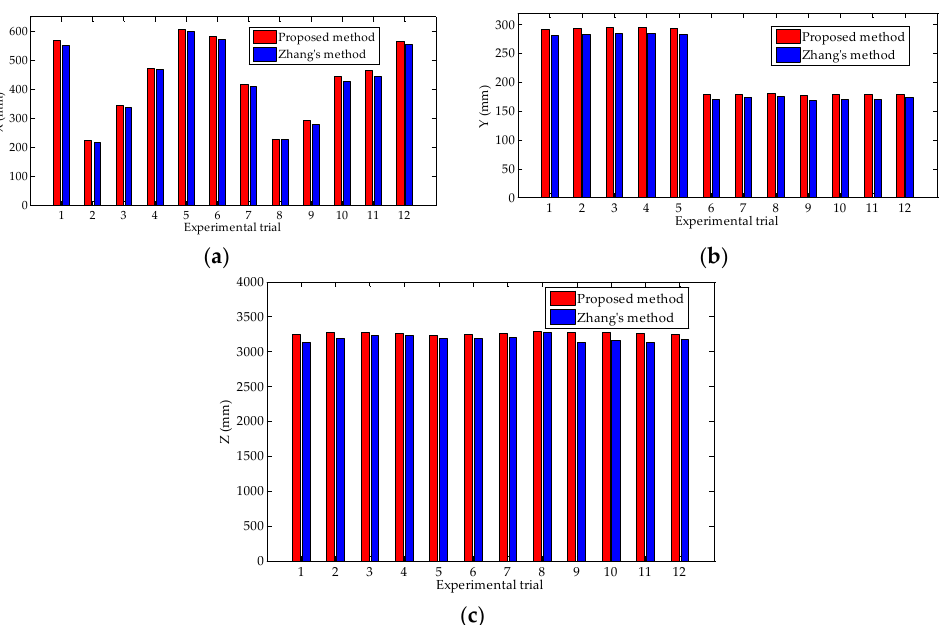
Figure 13. The 3D coordinates estimated by using the proposed method and Zhang’s method: ( a ) X of the two methods; ( b ) Y of the two methods; ( c ) Z of the two methods. Sensors 2018 , 18 , x FOR PEER REVIEW